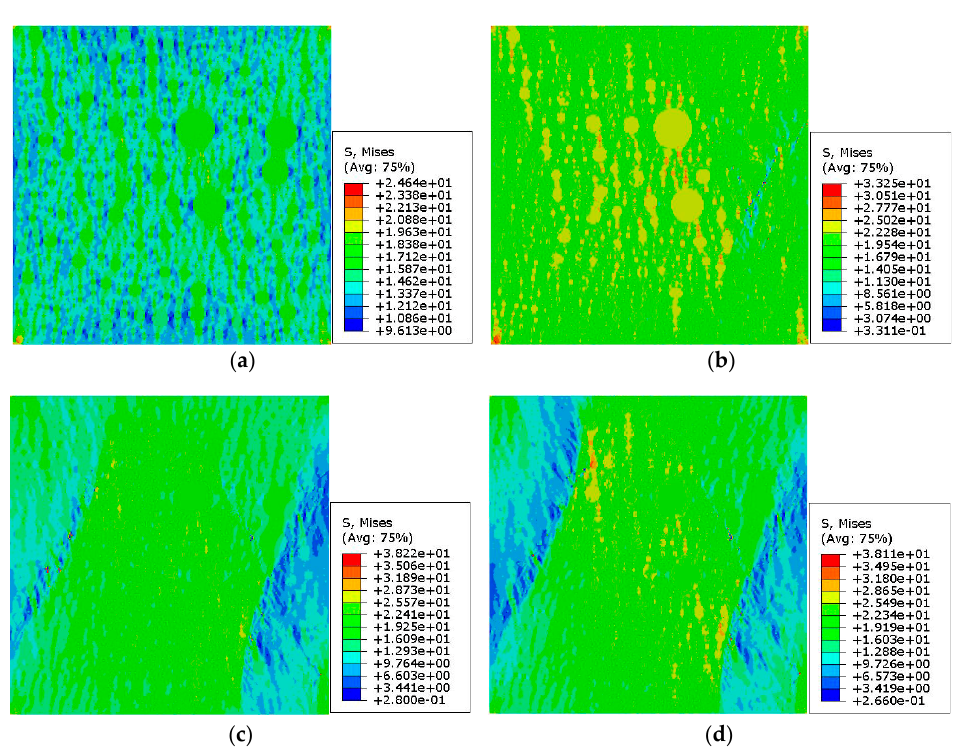
Figure 16. Stress nephogram of 2D RCA model for mortar (M2) with different strains: ( a ) ε = 0.03%; ( b ) ε = 0.1%; ( c ) ε = 0.3%; ( d ) ε = 0.45%.